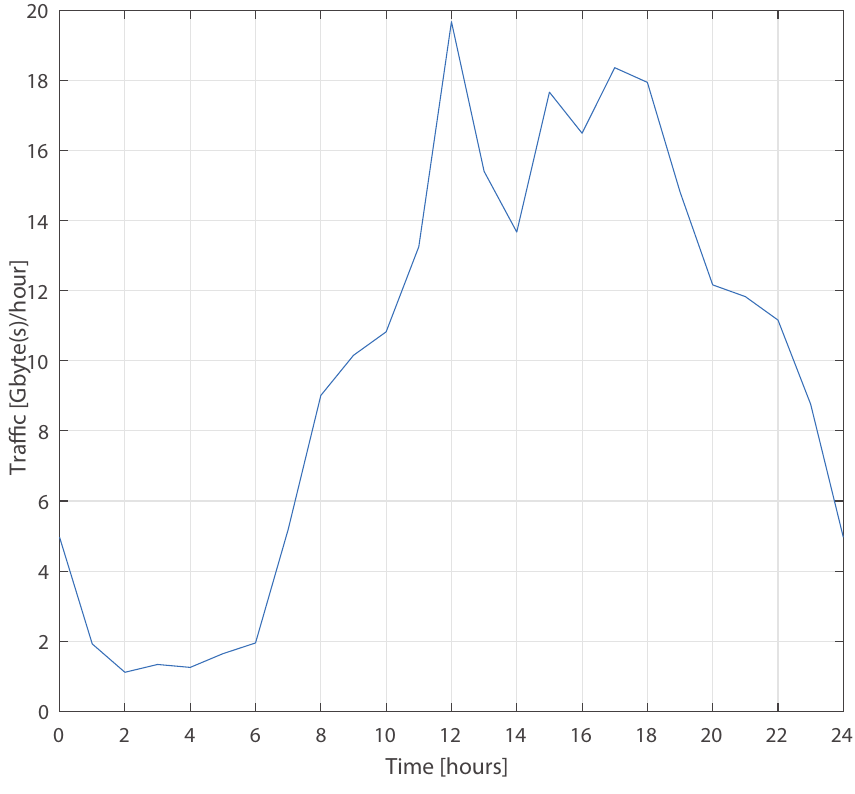
Figure 2. Measured traffic’s daily time variation